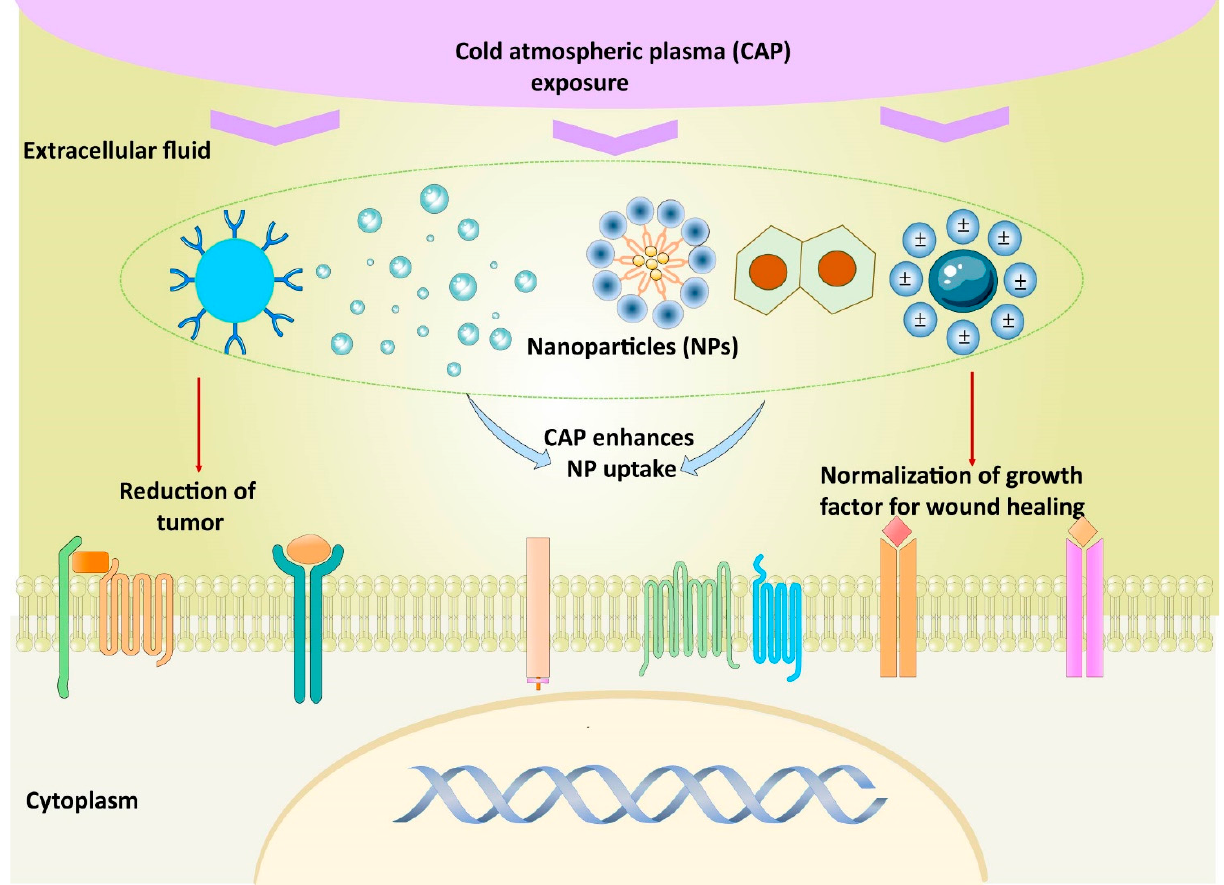
Figure 9. CAP provides a promising tool for nanomaterial-assisted tissue regeneration in plasma medicine. The symbol ± denotes the either positive or negative ions surrounding a NP with opposite charge. Table 2. Combination of NPs and CAP treatment in different types of